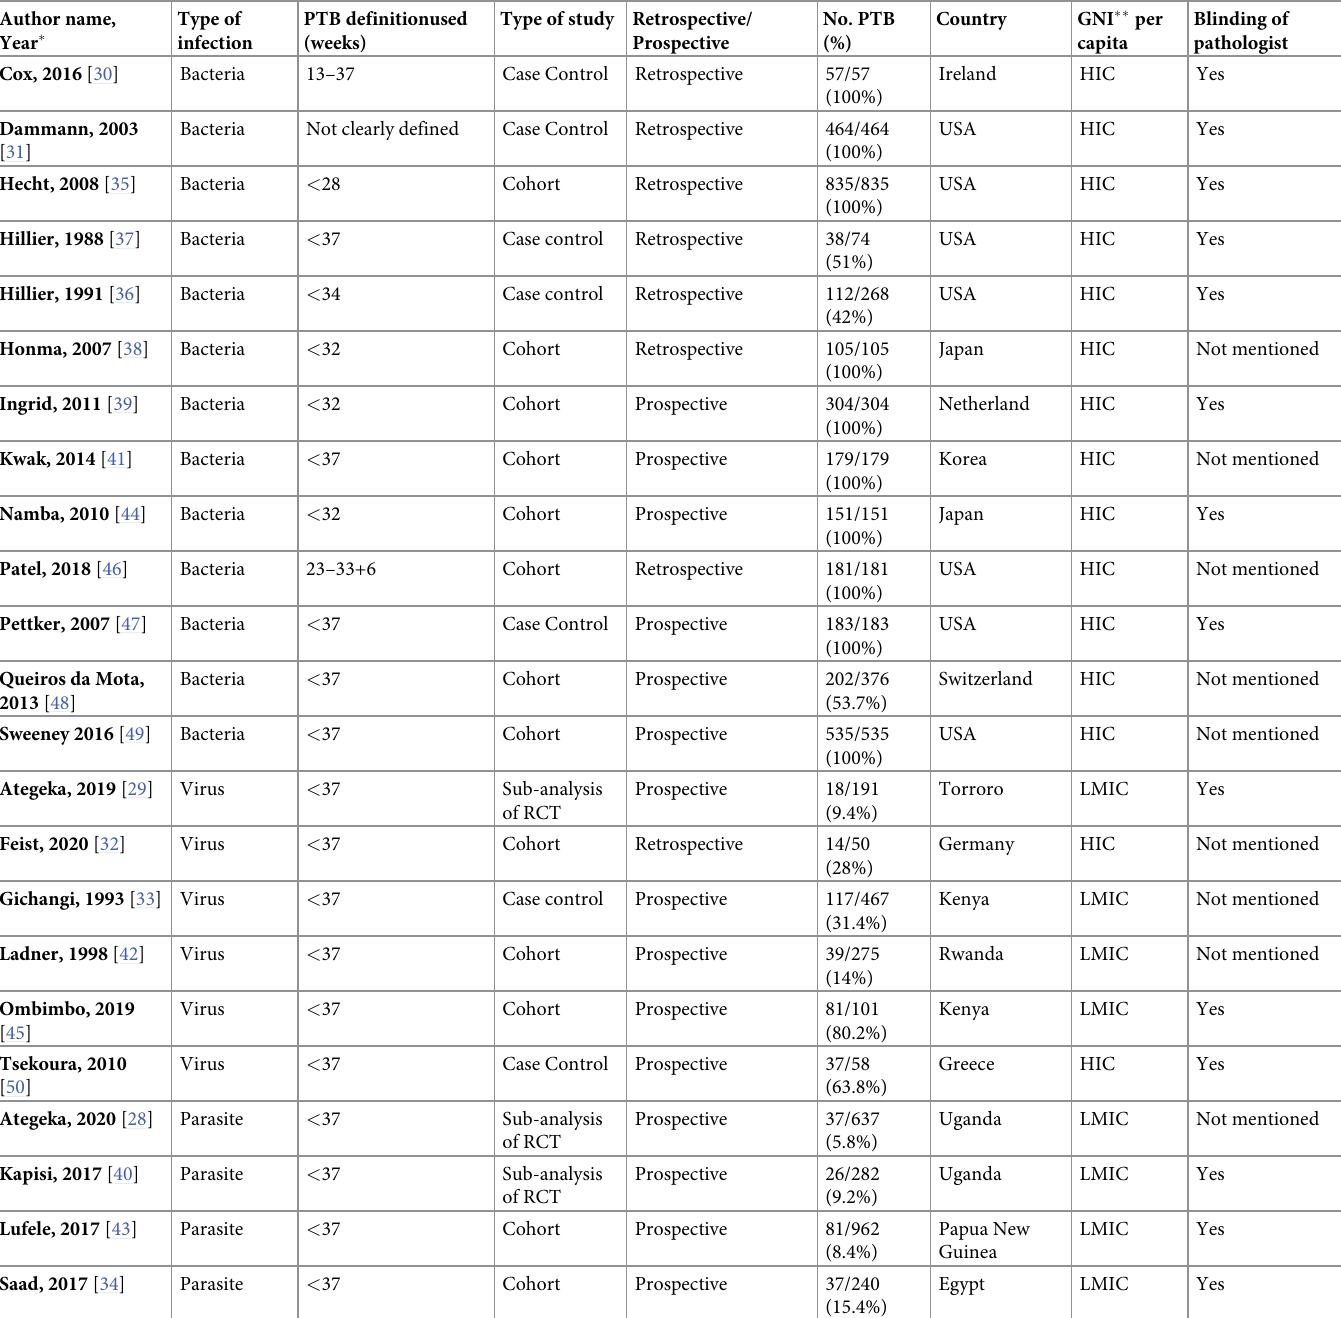
Table 1. Study characteristics. Author name, Year